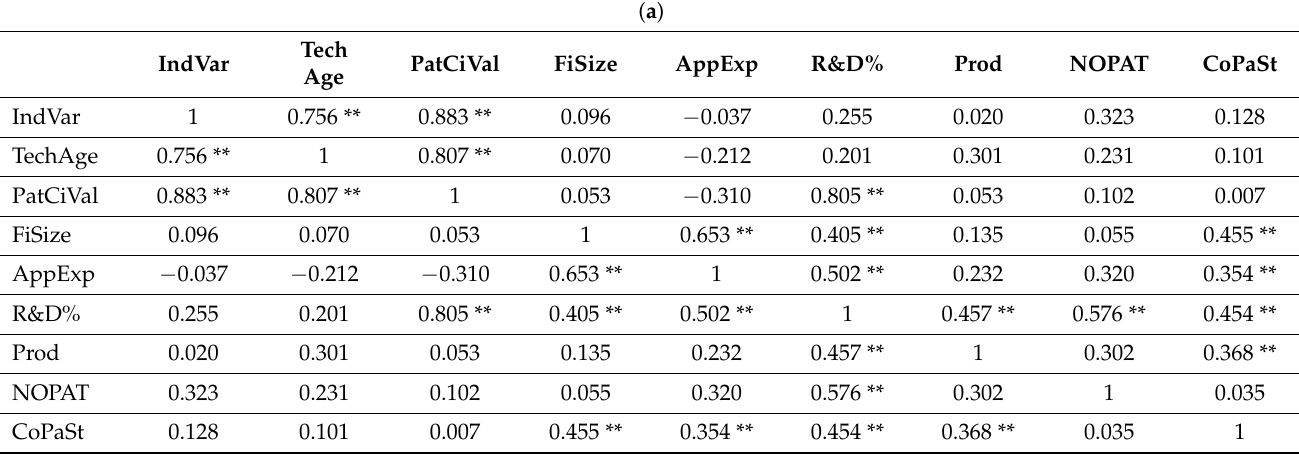
Table 2. (a) Correlation test for the Knowledge Flow model; (b) Correlation test for the Creativity Flow